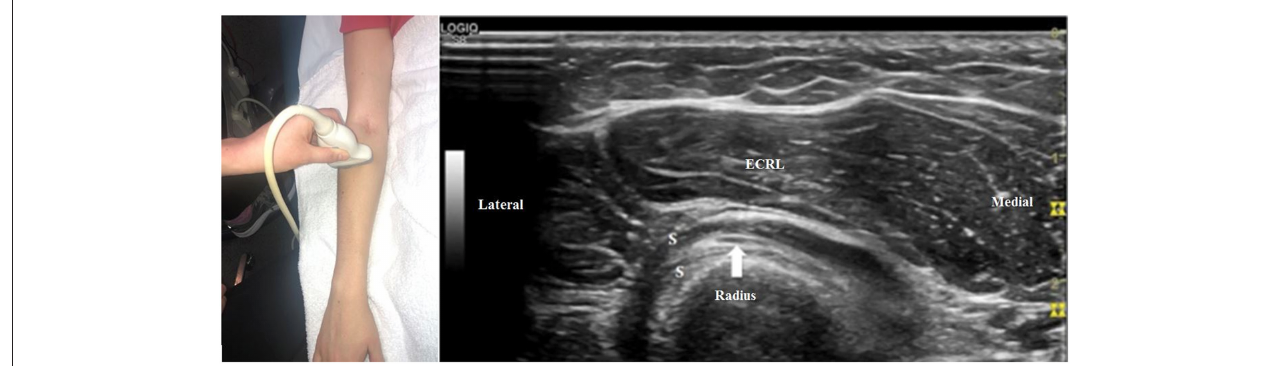
FIGURE 4 | The transducer is just distal to its position in Figure 3 . The motor branch of the radial nerve has now become the posterior interosseous nerve (arrow) and is imaged in a slightly oblique view between the two layers of the supinator (S). ECRL, extensor carpi radialis longus.